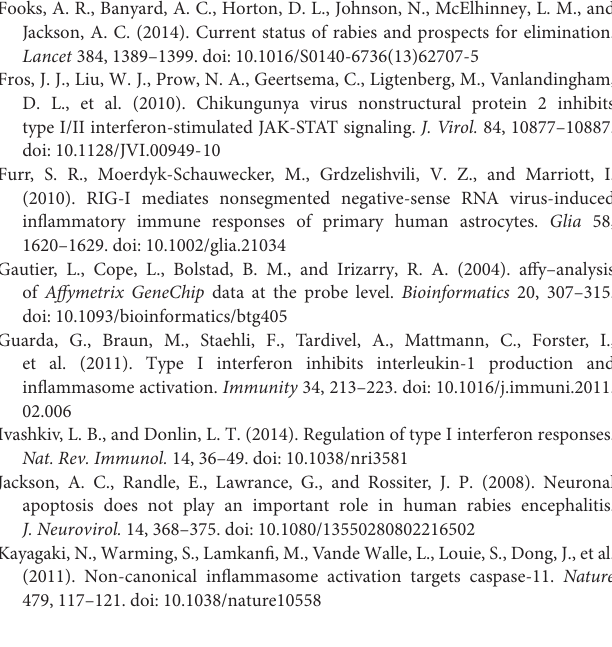
FIGURE S1 | Key apoptotic markers in DUVV-NL07- and RABV-PV-infected mice. Genomics data were confirmed by qRT-PCR for CASP-3, CASP-9, and TNF- α . Means and standard error of the mean are depicted in the plots. When differences are significant, the p -value is given (Mann–Whitney non-parametric